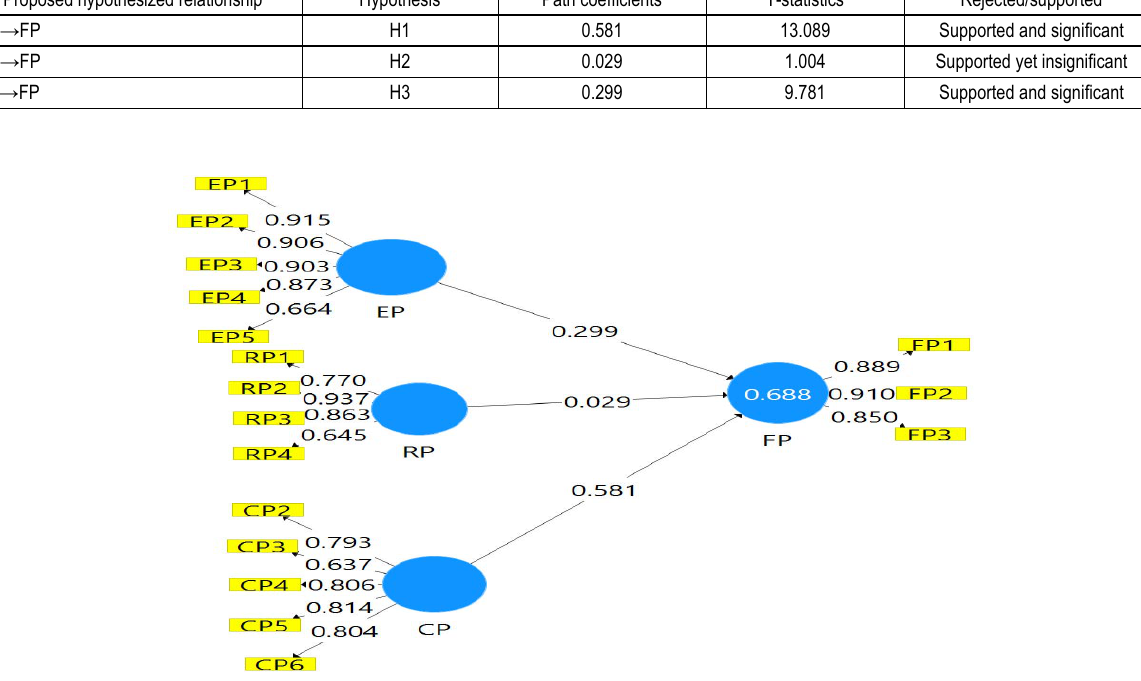
Fig. 1. SEM model of the EP, RP, CP, FP